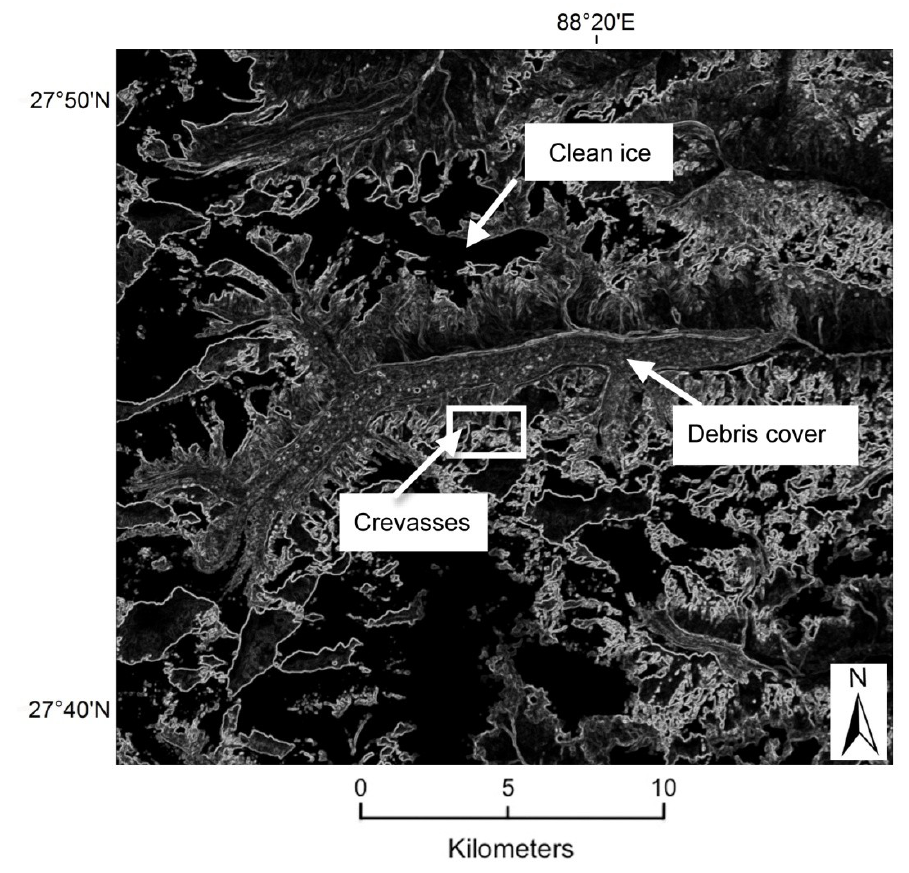
Figure 14. Results of the Sobel filter using a 3 × 3 moving window over the subset image. Debris cover is distinguished by a higher concentration of edges, including circular features (supraglacial lakes). Crevasses are also visible in this image, as a concentration of edges transversal to the flow